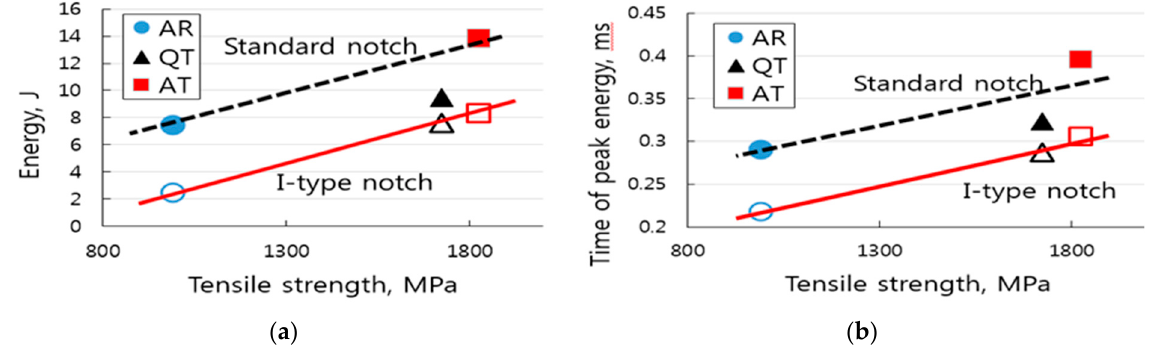
Figure 16. ( a ) Relationship between the tensile strength and the maximum Charpy impact energy and ( b ) relationship between the maximum impact time (ms) and tensile strength.